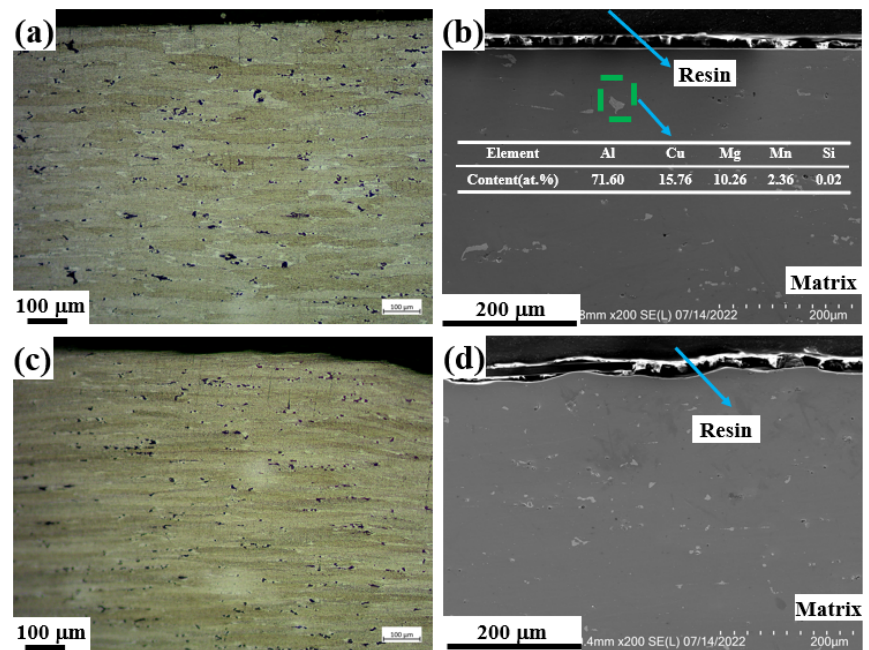
Figure 8. Residual stress distribution of the original and shot-peen-formed samples.